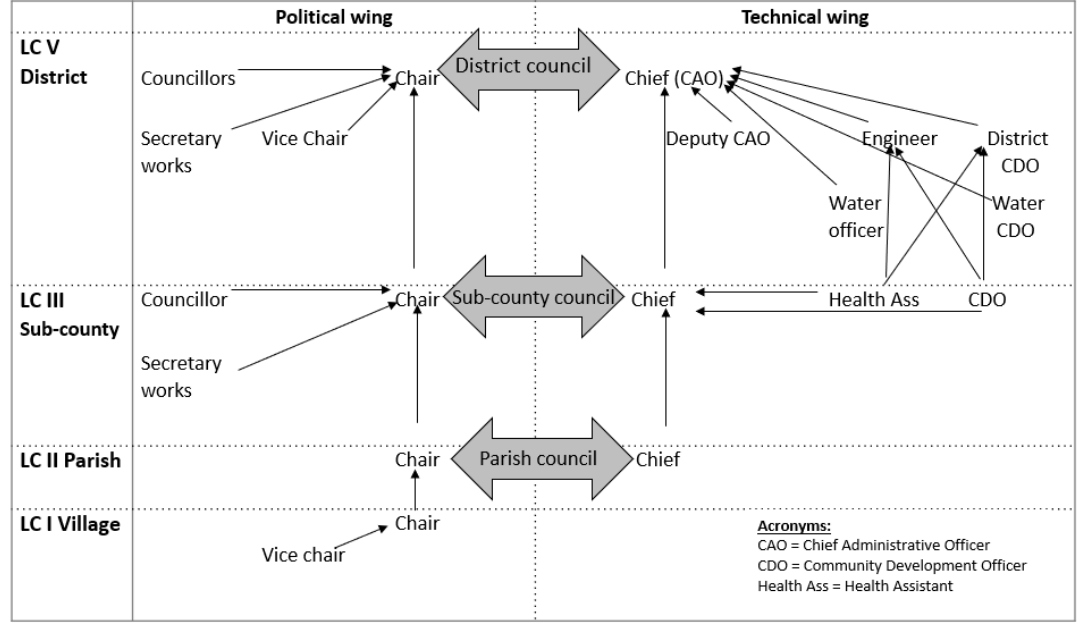
Figure 1: Reporting chain (minimal information-sharing